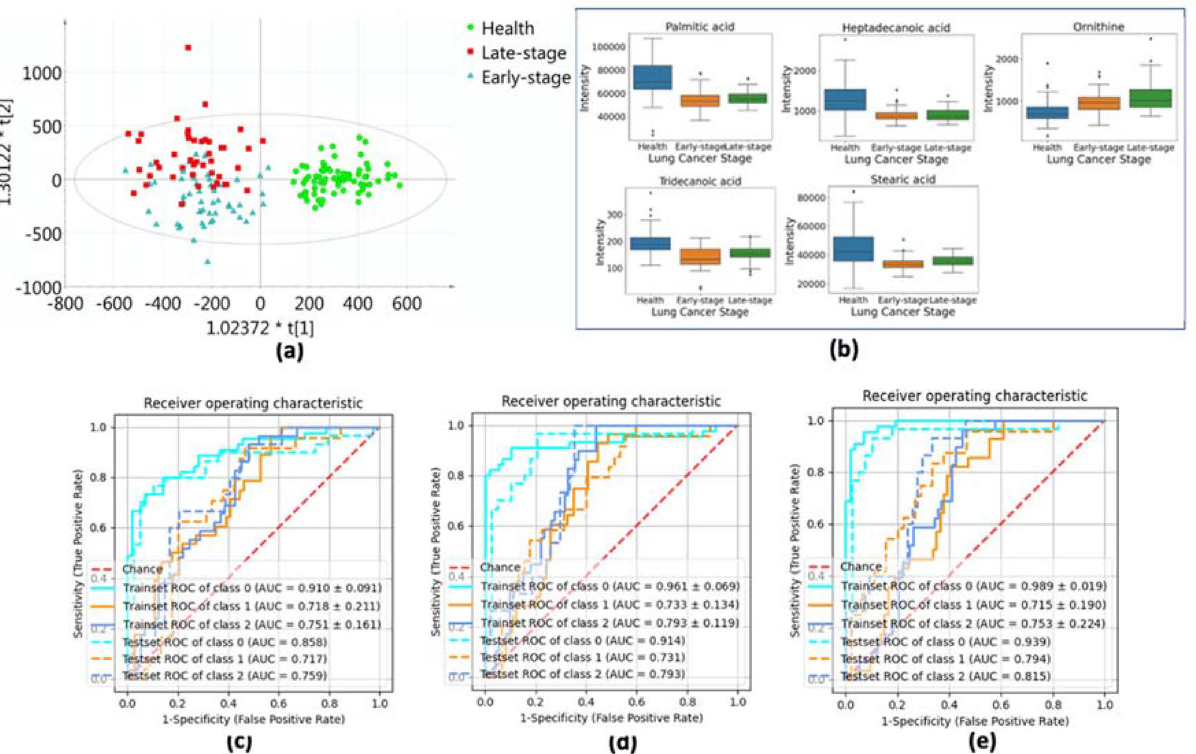
Figure 2. (a) Orthogonal projection on latent structure discriminant analysis (OPLS-DA) scores plot shows the ability to discriminate early-stage lung cancer patients, advanced-stage lung cancer patients and healthy controls. (b) Box and whisker plots for the top 5 most important metabolites between healthy control and different lung cancer stage groups. (c)-(e) Receiver-operating characteristic (ROC) curves for discriminating healthy controls, early-stage patients, and advanced-stage lung cancer patients, where class 0 represents healthy controls, class 1 represents early-stage patients, and class 2 represents advanced-stage patients [ (c) ROC curves of the logistic model using top 5 metabolomic markers; (d) ROC curves of the logistic model using top 10 metabolomic markers; (e) ROC curves of the logistic model using top 20 metabolomic markers].